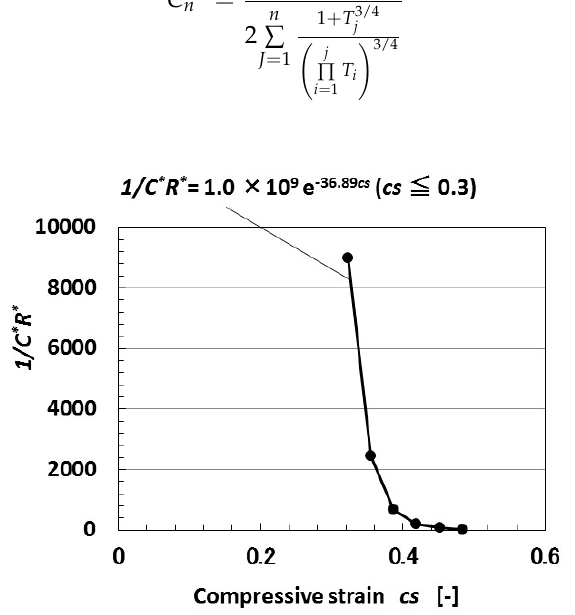
Figure 4. Theoretical results of 1/ C * R * to compression by tunneling theory.